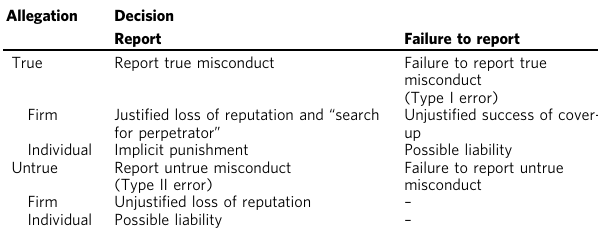
Table 1 Types of errors and